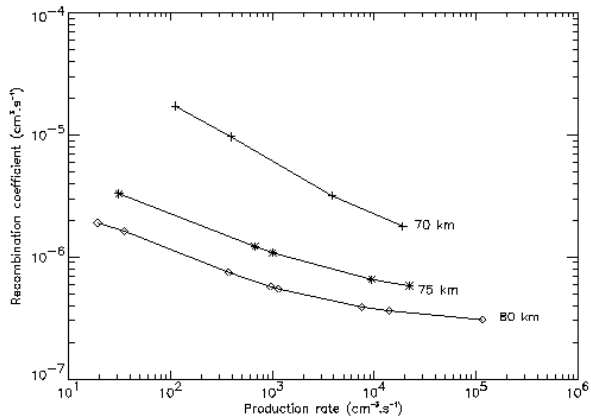
Fig. 10. Values of effective recombination coefficient computed from the Sodankyl¨a chemical model of the D-region. (After Harg- reaves and Howarth, previously unpublished)